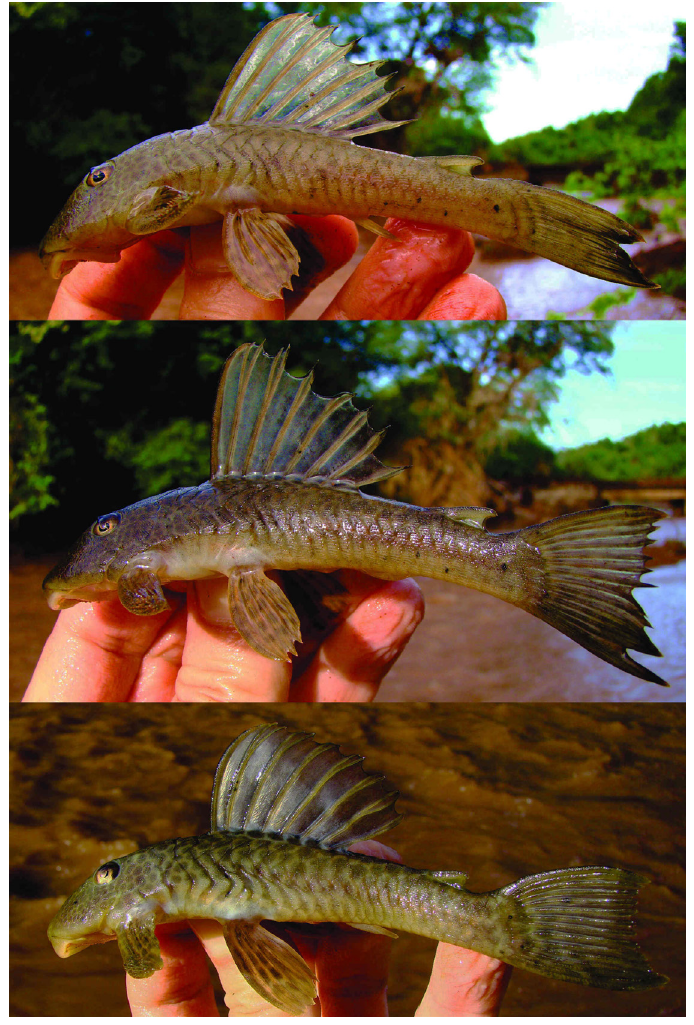
FIGURE 6 | Specimens of Hypostomus robertsoni in life, with inconspicuous dorsal fin dark